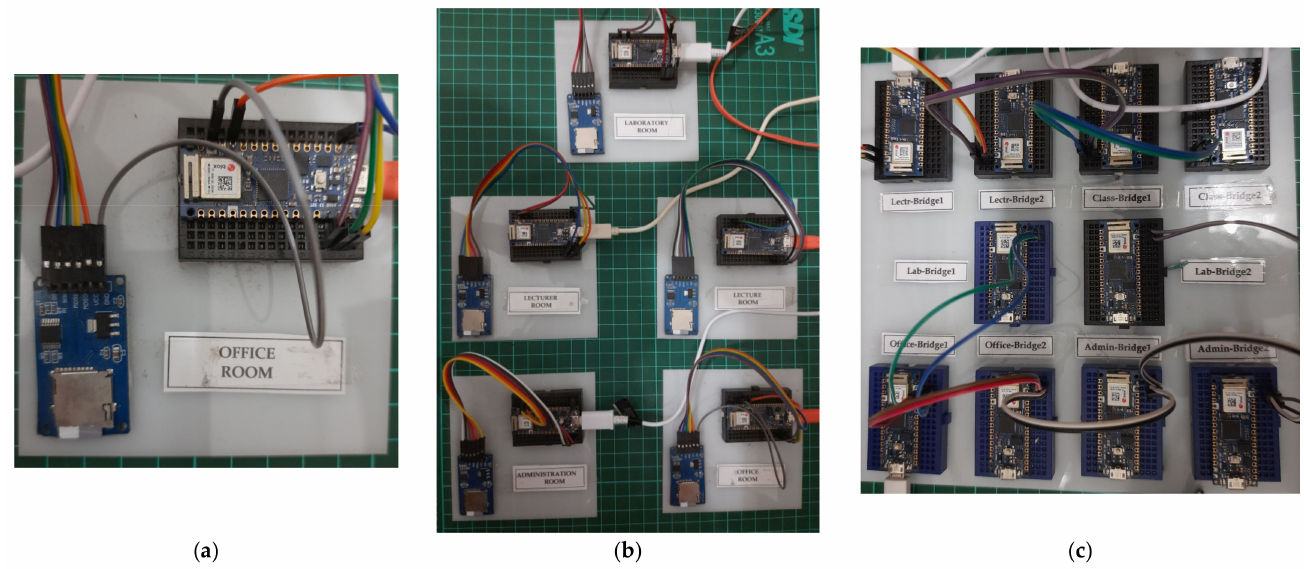
Figure 6. Photographs of the hardware prototypes: ( a ) main device; ( b ) group of main devices; ( c ) group of bridge devices.